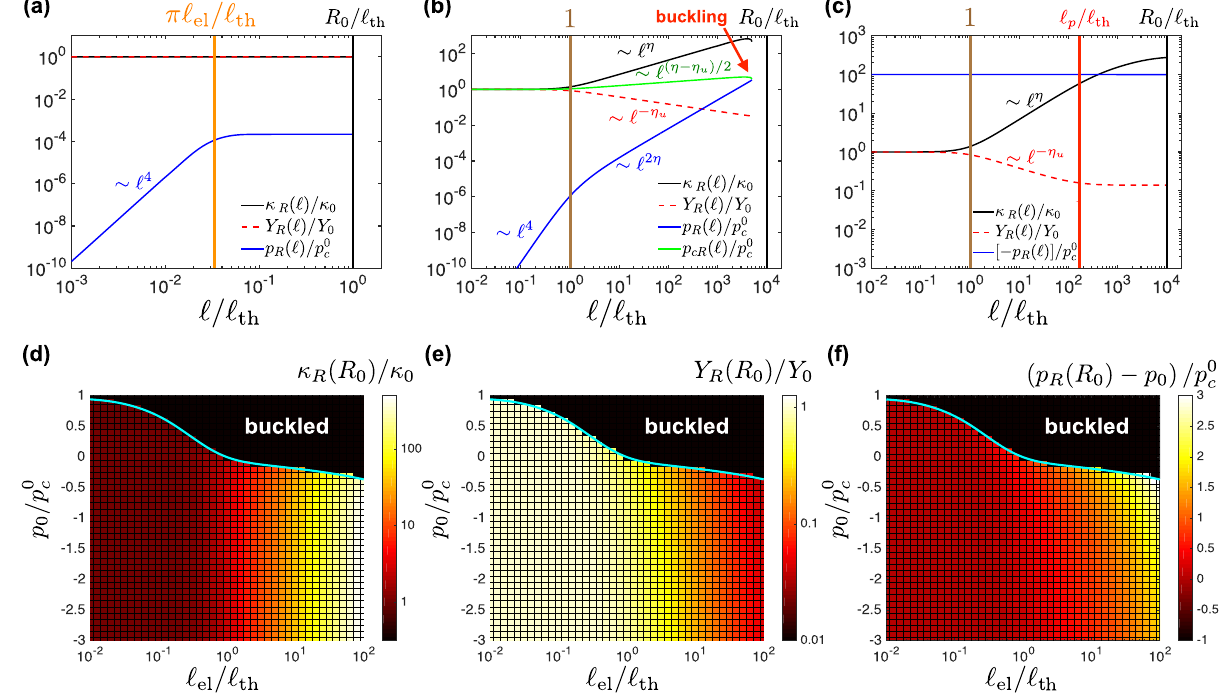
2 1 = 4 to κ FIG. 3. Typical renormalization group flows at various microscopic pressures p 0 and ratios of l ffiffiffiffiffiffiffiffiffiffiffiffiffiffiffiffiffiffiffiffiffiffiffiffiffiffiffiffiffiffiffiffiffiffiffi p 0 R 0 =Y 0 Þ el ¼ ð l 16 π 3 κ 2 3 k 10 − 2 , R l 1 , a=R 10 − 6 , and zero TY 0 Þ = l . (a) Spherical shells at low temperature with l 0 = 0 ¼ 0 = ð B th ¼ el th ¼ th ¼ external pressure ( p 0 ¼ 0 ). In this case, there is practically no renormalization of the elastic constants κ and Y , while the R R renormalization of the thermally generated external pressure p is cut off at l ≈ π l . (b,c) Spherical shells at high temperature with R el l 10 2 , R l 10 4 , a=R 10 − 6 , and (b) zero external pressure ( p 0 ) or (c) large stabilizing outward pressure = l 0 = 0 ¼ 0 ¼ el th ¼ th ¼ − 100 ). In both of these cases, the elastic constants κ ( p 0 =p 0 and Y initially renormalize in the same way as flat membranes c ¼ R R [see Eq. (20)]. In case (b), even in the absence of external pressure p 0 ¼ 0 , this large shell buckles because the thermally generated l Þ eventually reaches the renormalized critical buckling pressure p l Þ . In case (c) with a large outward pressure inward pressure p R ð cR ð ∼ = l ( p 0 < 0 ), spherical shells remain stable and the renormalization of elastic constants is cut off at the scale l p th ð p 0 c = j p 0 jÞ 1 = ð 2 − η Þ ð l el = l th Þ 2 = ð 2 − η Þ ∼ ð k B TY 0 = j p 0 j R 0 κ 0 Þ 1 = ð 2 − η Þ , which is analogous to the cutoff provided by an outward in-plane tension TY 0 =R 0 κ 0 (not shown), the renormalization of κ and Y is in flat solid membranes [82]. For sufficiently large internal pressure p 0 ≲ − k B R 0 Þ , (e) the renormalized Young ’ s modulus Y R 0 Þ , completely suppressed. (d – f) Heat maps of (d) the renormalized bending rigidity κ R ð R ð R 0 Þ − p 0 evaluated at the scale of the shell radius R 0 . In (d – f), and (f) the thermally induced part of renormalized external pressure p R ð 10 2 and a=R 10 − 6 . The large black buckled region is a direct consequence of thermal fluctuations, and its border, we used R 0 = l 0 ¼ el ¼ denoted with a solid cyan line, corresponds to the critical buckling pressure in Eqs. (34) and (35) displayed as the solid black curve in Fig. 5. Note that both positive (inward) and negative (outward) pressures appear along the y